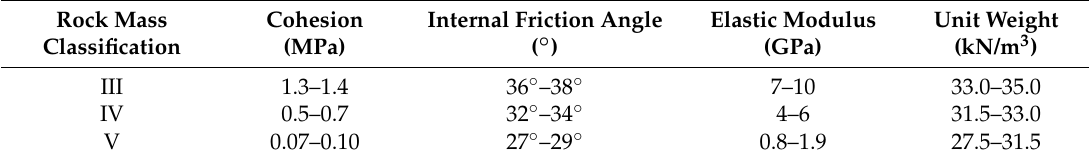
Table 1. Physical and mechanical parameters of three different classes of rock masses (class III, class IV and class V